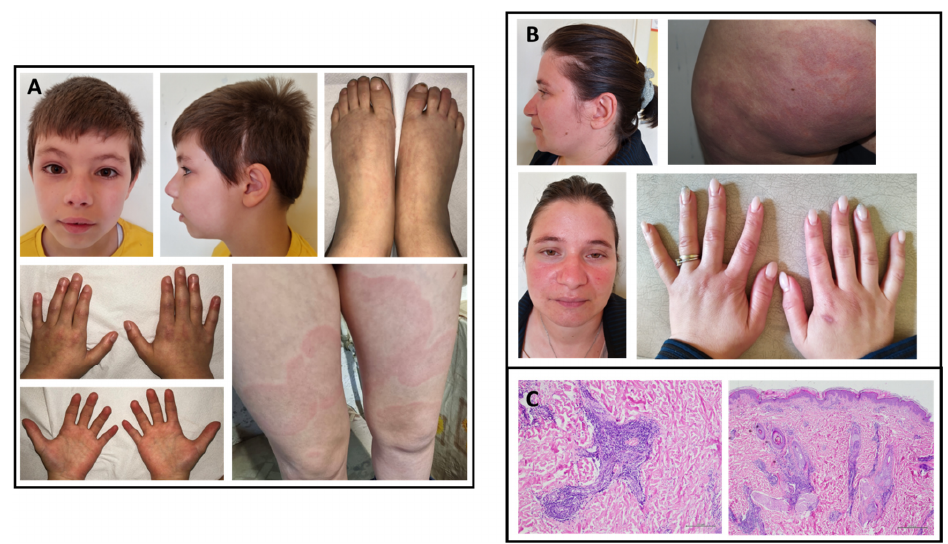
Figure 3. Clinical pictures and histological images of proband and his carrier mother from family C. Proband (III.3; family C) shows some facial peculiarities such as arched eyebrows, mild retrognathia, scalp scar due to neurosurgery, livedo reticularis of hands, feet, and legs, and skin lesions compatible with annular figurate erythema involving both upper legs ( A ). Proband’s mother (II.2) shows no dysmorphic features but presents livedo reticularis and annular figurate erythema ( B ). Histological images of skin biopsy samples taken from the mother (hematoxylin and eosin staining; 4× and 10× magnification), showing a dense perivascular lymphocytic infiltrate involving both superficial and deep dermal vascular plexus. Epidermis was normal ( C ).